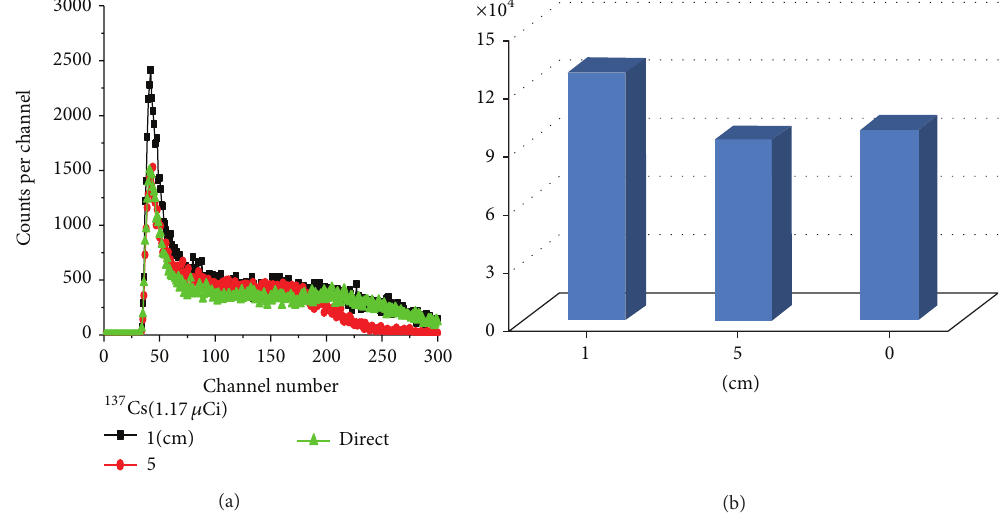
Figure 6: Pulse height spectra on the distance between the radiation sensor and